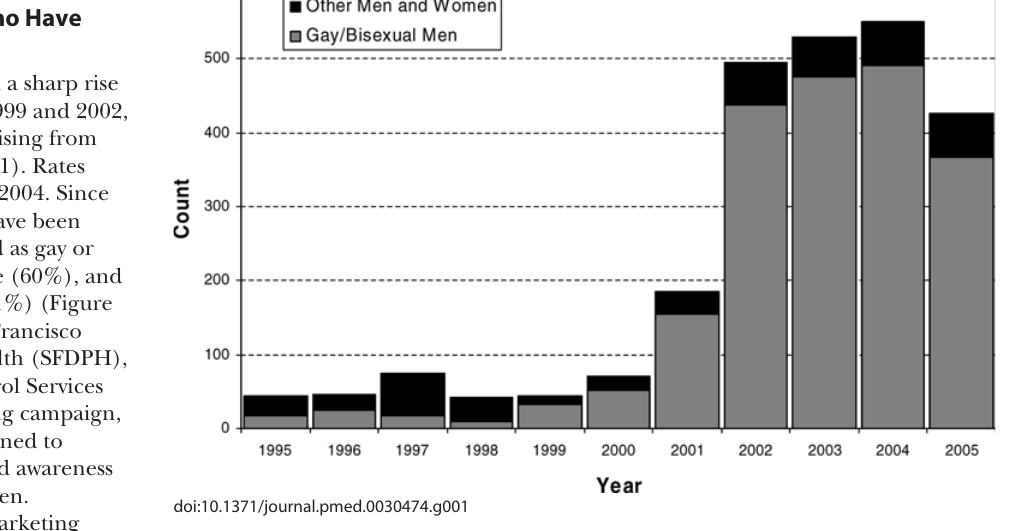
Figure 1. Proportion of Early Syphilis Cases among Gay/Bisexual Men in San Francisco,